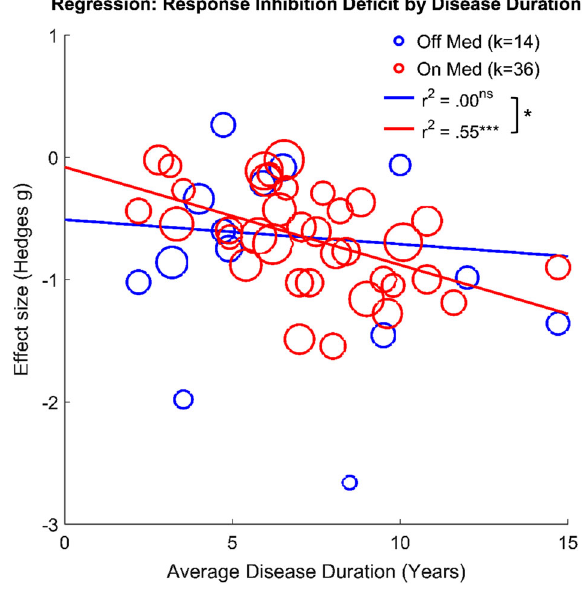
Fig. 3 Regression plot of response inhibition de fi cits on average disease duration for the “ off ” medication ( blue ) and “ on ” medication ( red ) samples. Effect sizes less than 0 indicate that PD patients demonstrated poorer response inhibition performance than healthy controls. Each bubble represents a comparison from one study, weighted by within-study variance. Smaller bubbles represent studies with higher variance than others and thus, have less in fl uence on the regression. The regression line of best fi t for each sample is also shown. The difference in slopes was signi fi cant ( z test; p = .04), indicating that “ off ” medication, de fi cits were moderate and relatively unaffected by disease duration, whereas “ on ” medication, de fi cits were signi fi cantly associated by disease duration. * p < .05; *** p =